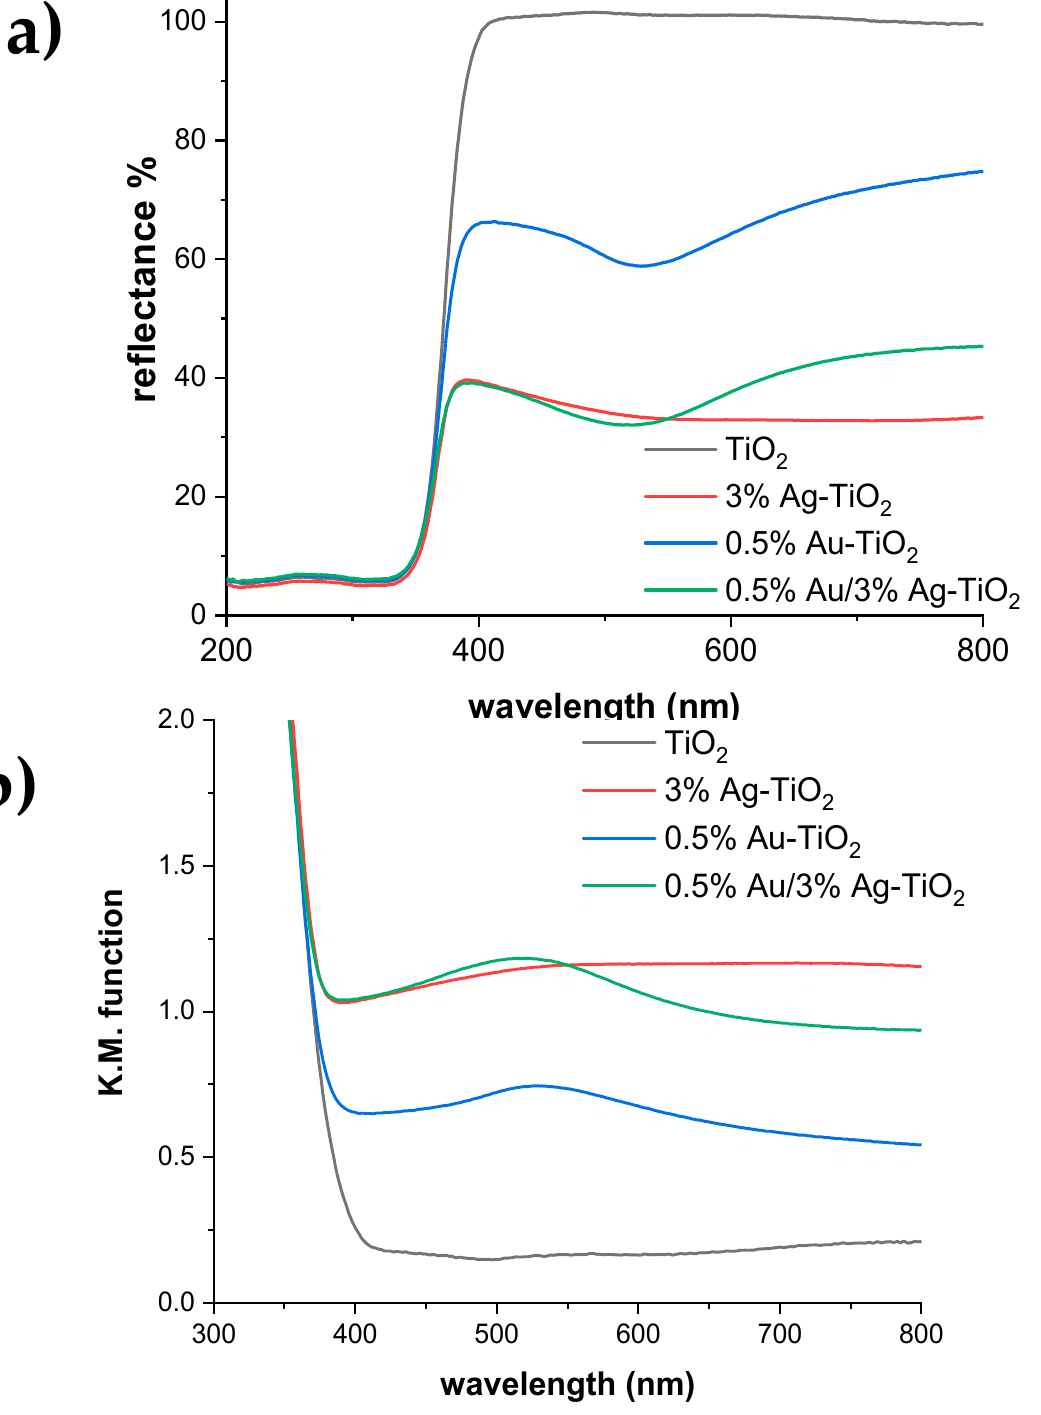
Figure 10. ( a ) DR spectra and ( b ) relative absorbance spectra for pristine and metal-promoted TiO 2